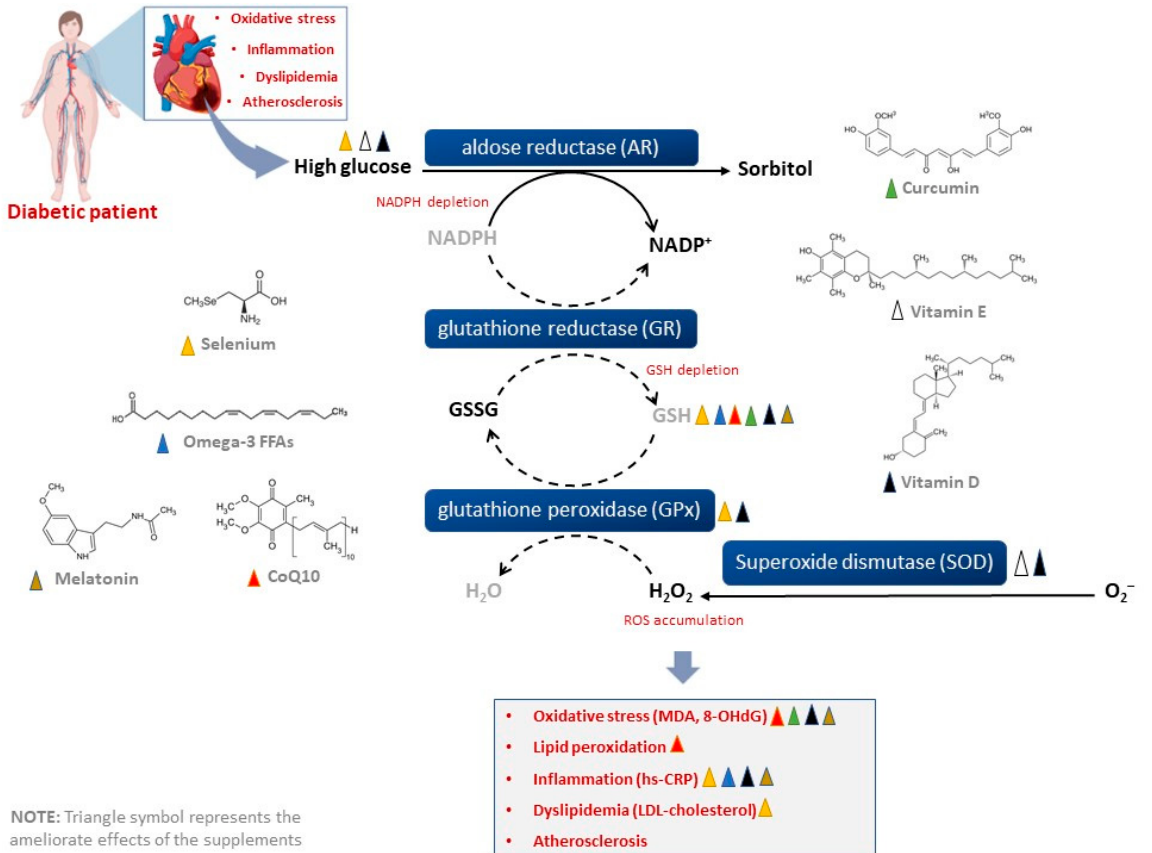
Figure 3. Dietary supplements such as coenzyme Q 10 , selenium, curcumin, omega-3 fatty acids, and vitamin E or D can potentially enhance intracellular antioxidants (including glutathione) to improve cardiometabolic health in diabetic patients. These effects are associated with reduced low-density lipoprotein-cholesterol, oxidative stress, and inflammation, while improving blood glucose control and blocking the destructive effects of sorbitol. Abbreviations; GSSG: glutathione disulfide, GSH: glutathione, MDA: malondialdehyde, 8-OHdG: 8-hydroxyguanosine, NADP(H): nicotinamide ad- enine dinucleotide phosphate, hs-CRP: high sensitivity C-reactive protein, LDL: low-density lipo- protein, ROS: reactive oxygen species.